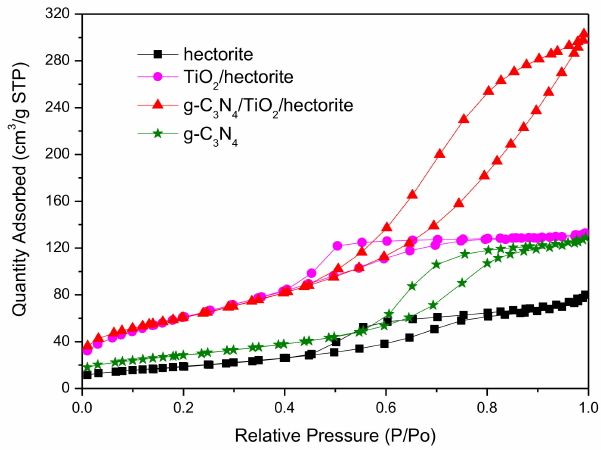
Figure 3. N 2 adsorption and desorption isotherms of hectorite, TiO 2 / hectorite, g-C 3 N 4 and g-C 3 N 4 / TiO 2 /